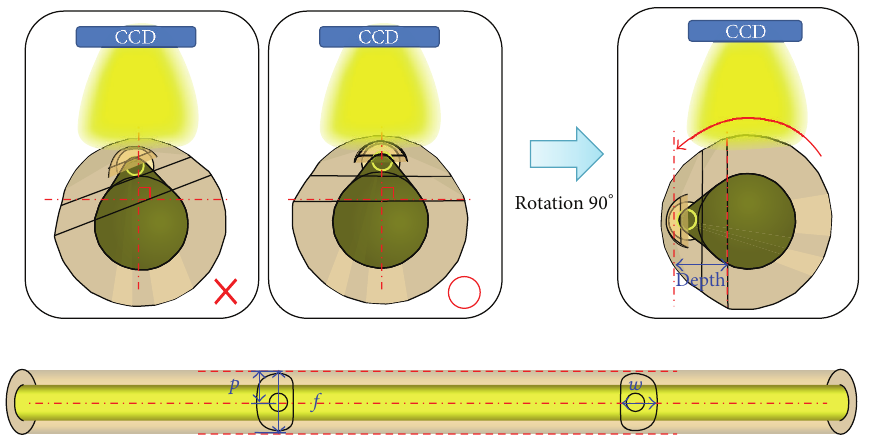
Figure 5: Image measurement technique.